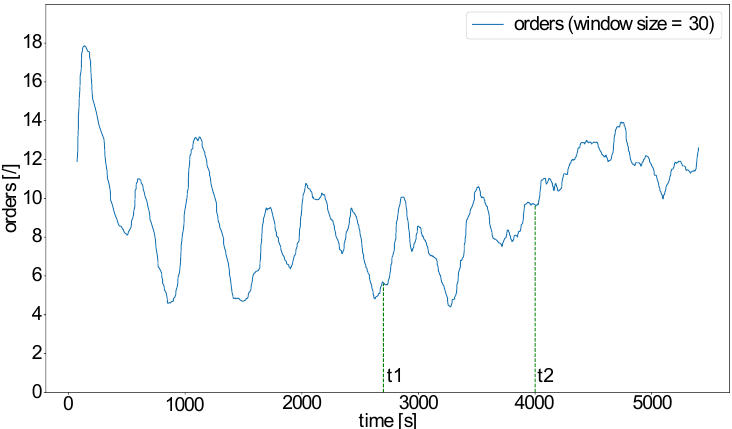
Figure 6. Number of service orders over